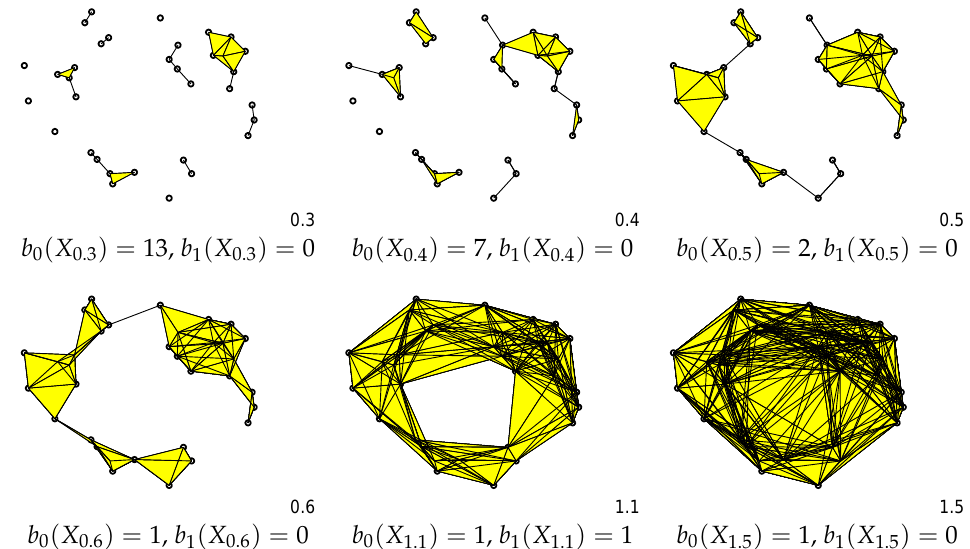
Figure 4. Vietoris–Rips complexes constructed out of a plane dataset for different values of the threshold δ and their Betti